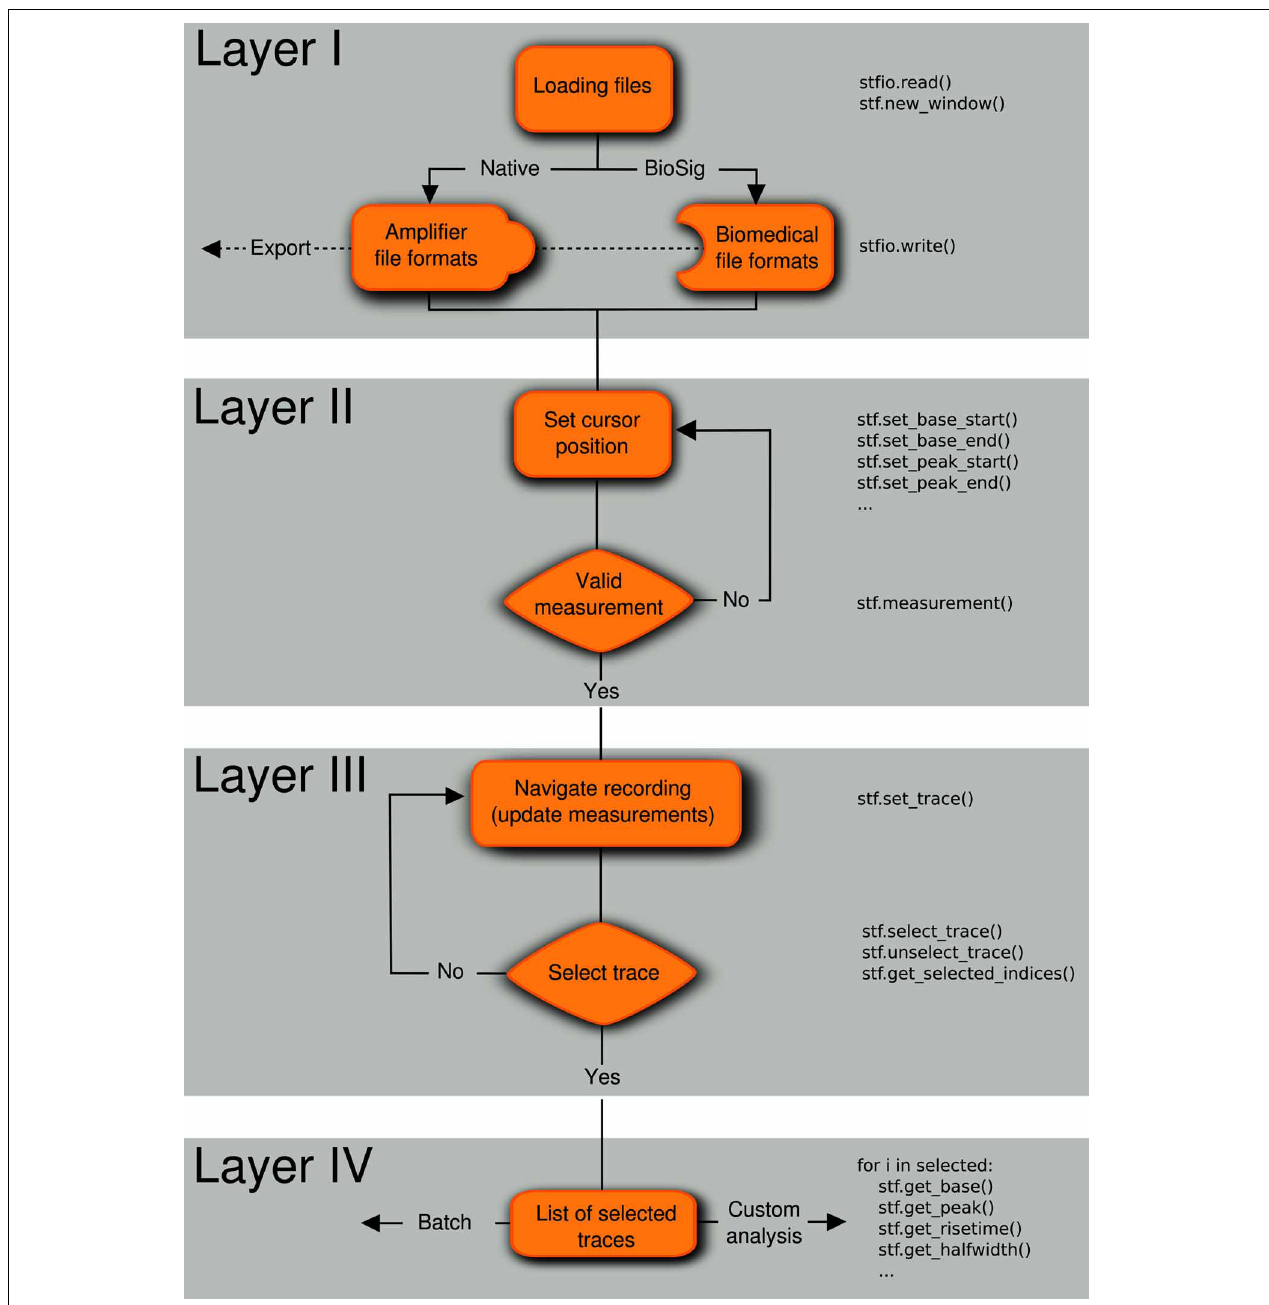
FIGURE 1 | Analysis workflow. A four-layered analysis workflow that includes (I) loading/exporting the recordings from/to various file formats, (II) setting the location of the cursors in the regions of interest, (III) navigating through the traces to select experiments matching inclusion criteria, and (IV) applying